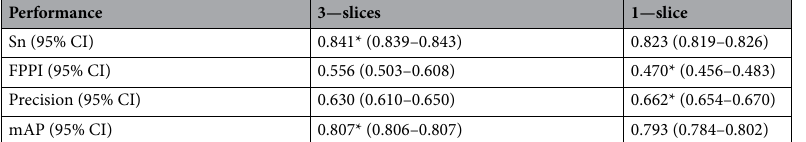
Table 2. Comparison of performance according to data. CI confidence interval, Sn sensitivity, FPPI false positive per image, mAP mean average precision. *Highest values of comparison parameters.